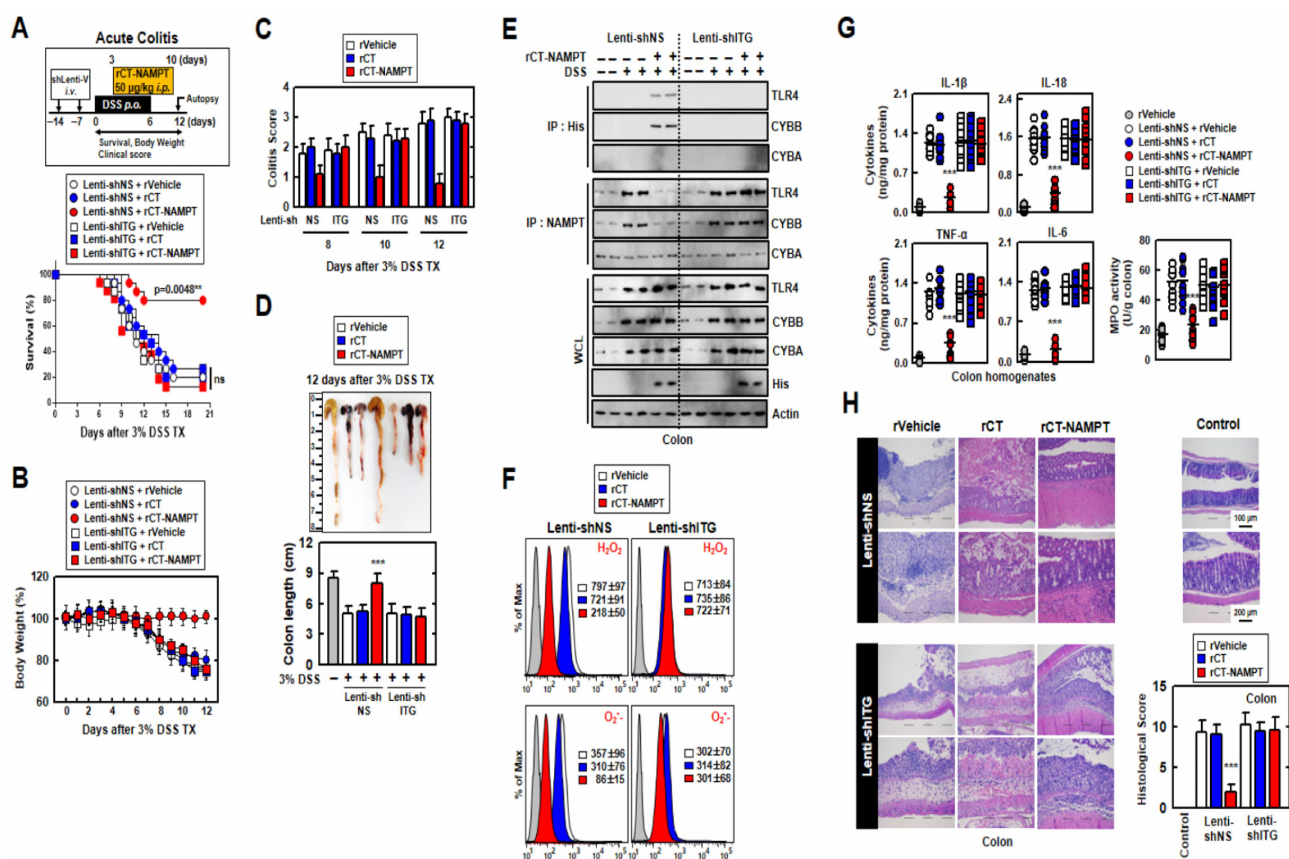
Figure 6. rCT-NAMPT has a medicinal effect against acute DSS-induced colitis in mice. ( A ) Scheme of the acute model of colitis transduced with Lenti-shNS or Lenti-shITG virus and subjected to 3% DSS with rCT-NAMPT (50 µ g/kg) (upper). The survival of mice was monitored for 12 days; mortality was measured for n = 15 mice per group (lower). The statistical differences between the rVehicle-treated animals are noted (log-rank test). The data come from two different experiments that yielded comparable results. ( B ) Weight loss ( n = 8). ( C ) Colitis scores were obtained from clinical parameters (weight loss, stool consistency, bleeding) ( n = 8). ( D ) Image (upper) and length (lower) of colon in 3% DSS-treated mice with rVehicle, rCT or rCT-NAMPT ( n = 8). ( E ) Colon was used for IP with α His or α NAMPT, followed by IB with α TLR4, α CYBB or α CYBA. WCLs were used for IB with α TLR4, α CYBB, α CYBA, α His or α Actin. ( F ) FACS analysis for cellular ROS from colon ( n = 8). ( G ) Levels of cytokines and MPO activity in colon homogenates ( n = 10). ( H ) Hematoxylin and eosin (H&E) staining of the colon (left) ( n = 10): representative imaging Histopathology scores were assessed in 3% DSS-treated mice with rVehicle, rCT, or rCT-NAMPT using H&E staining, as indicated in techniques (Materials and Methods). Statistical significance was assessed using the Student’s t -test with the Bonferroni correction (*** p < 0.001) in comparison to